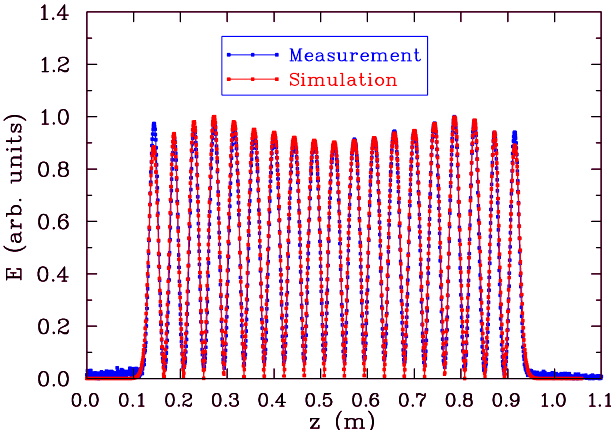
FIG. 24. (Color) This field distribution has been obtained by installing 3 tuners at each cavity end with a height of 30 mm.